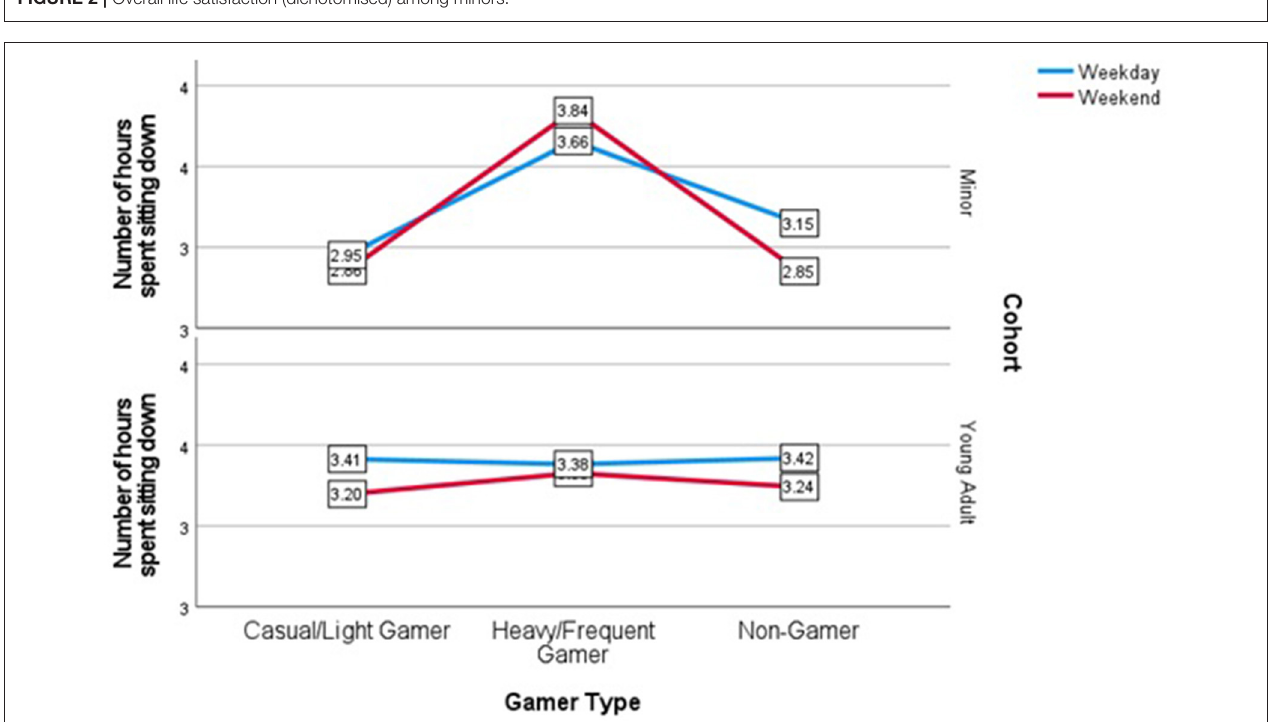
FIGURE 3 | Means plot of hours sitting down on weekdays and